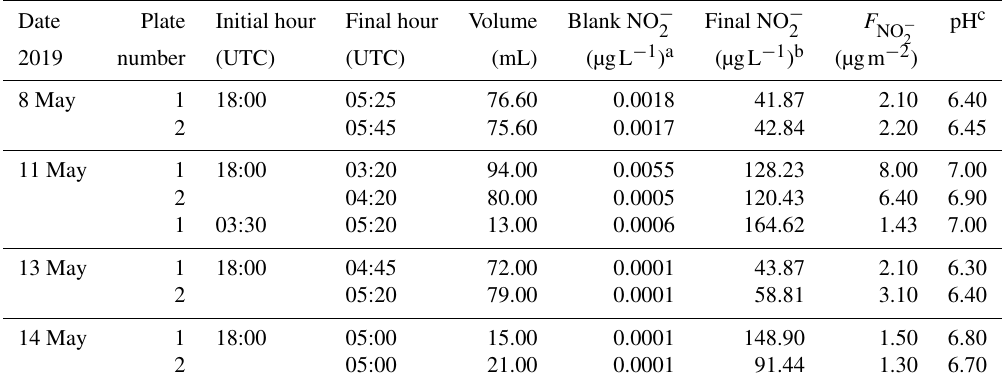
Table 2. Nitrite concentration measured in dew